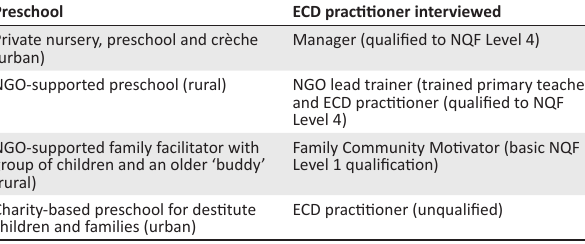
TABLE 1: Preschools and practitioners who took part in the